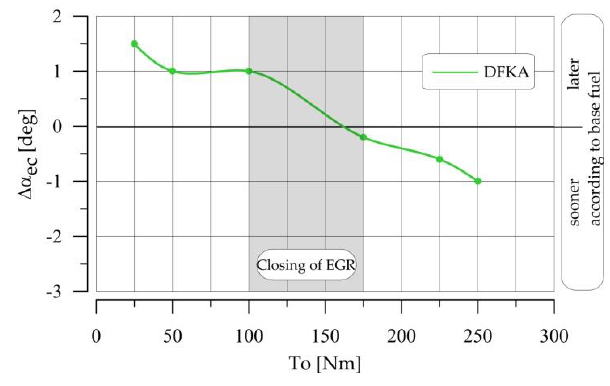
Fig. 13. Heat release rate in the cylinder of the diesel engine [7]: Fig. 15. Angular difference of the end of combustion (Δα ec ) of the VW 1.9 |  – fuel evaporation phase,  – kinetic combustion phase,  – diffusion TDI engine powered with the test fuel in relation to the base fuel [7] combustion phase